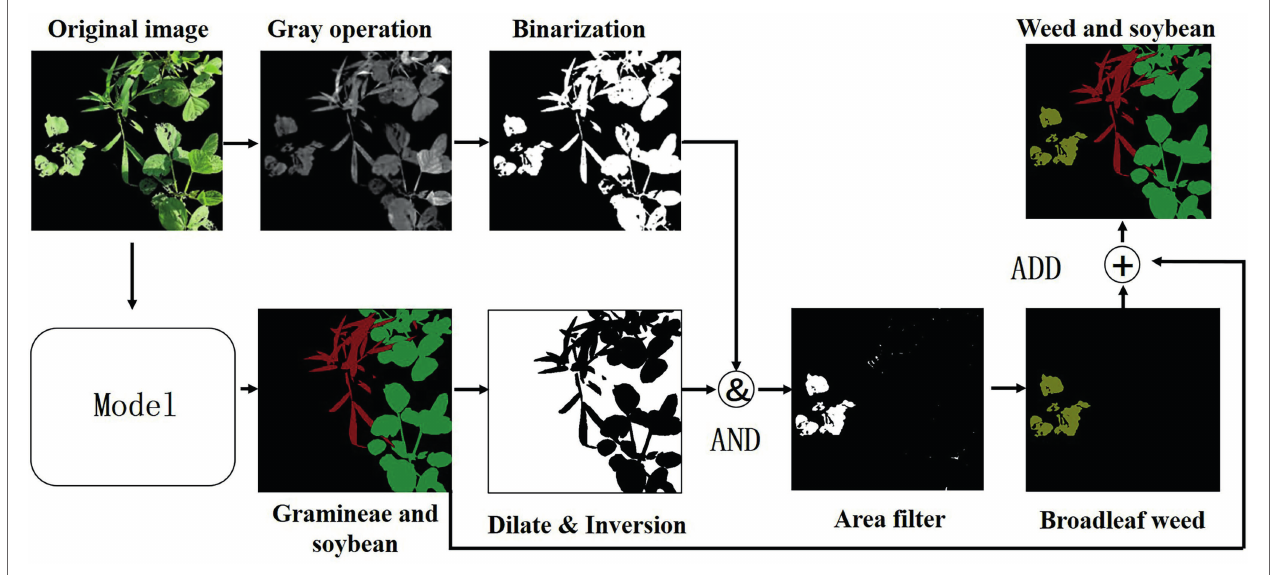
FIGURE 9 | Broadleaf weed extraction process.